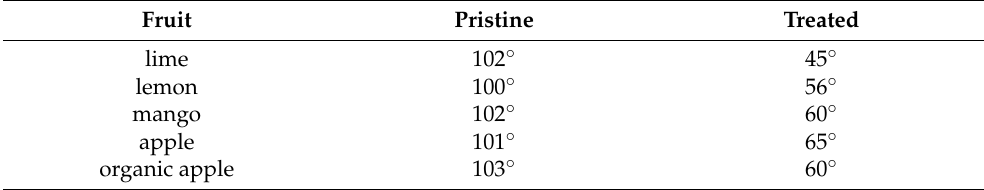
Table 2. Contact angle of a DI water droplet measured on the pristine and PDD treated